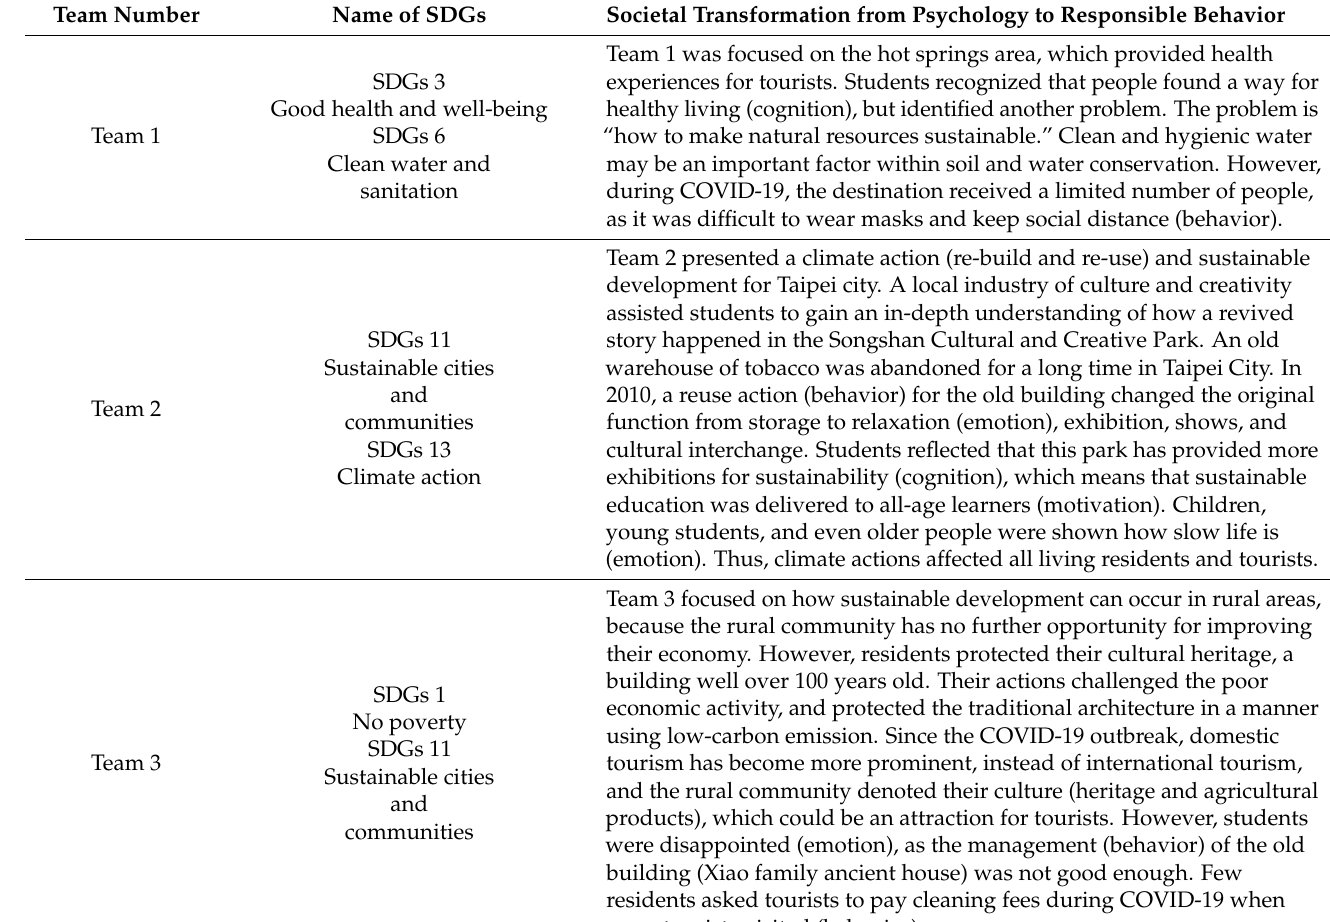
Table 2. Societal transformation of students from tourism